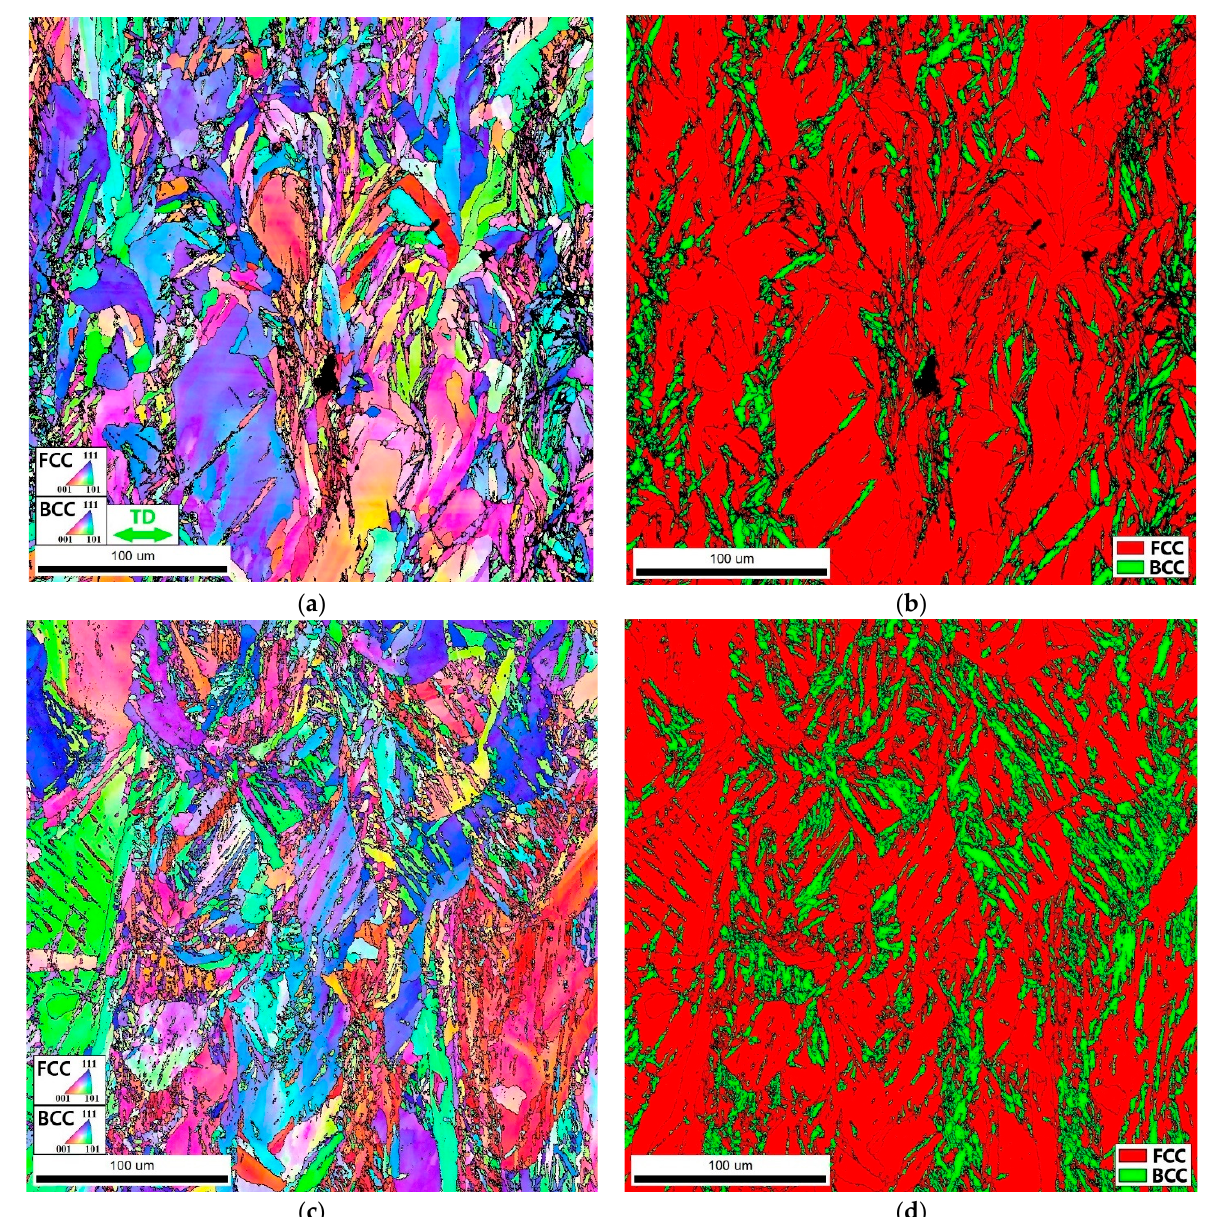
Figure 11. IPF ( a , c ) and phase ( b , d ) maps of the as-produced (mode: P = 200 W and V = 1600 mm/s) Fe 65 (CoNi) 25 Cr 9.5 C 0.5 alloy after interrupted tension to ε = 5% ( a , b ) and ε = 10% ( c , d ) at cryogenic temperature. The tension axis was horizontal in all cases.